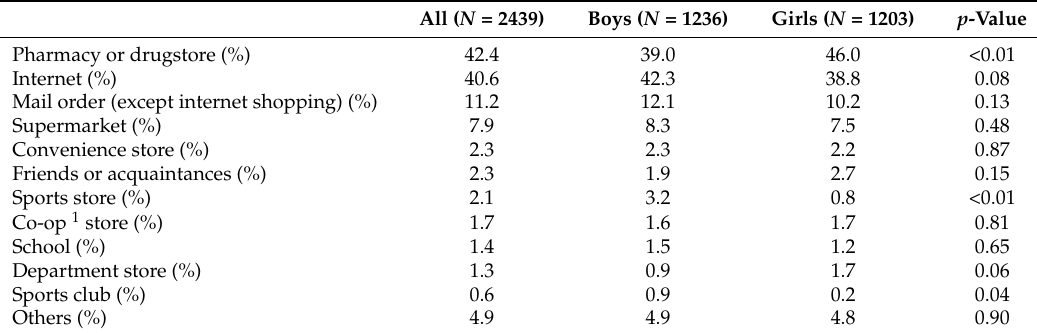
Table 4. How do you obtain dietary